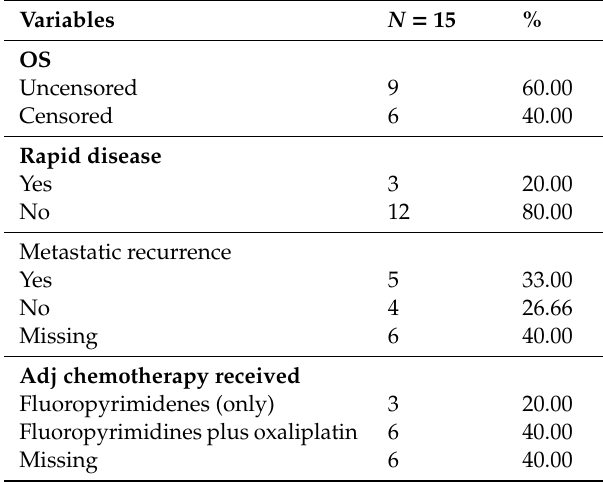
Table 3. Bruton’s tyrosine kinase (BTK) immunohistochemistry (IHC) ≥ 80% and intensity 3: treatment received and disease